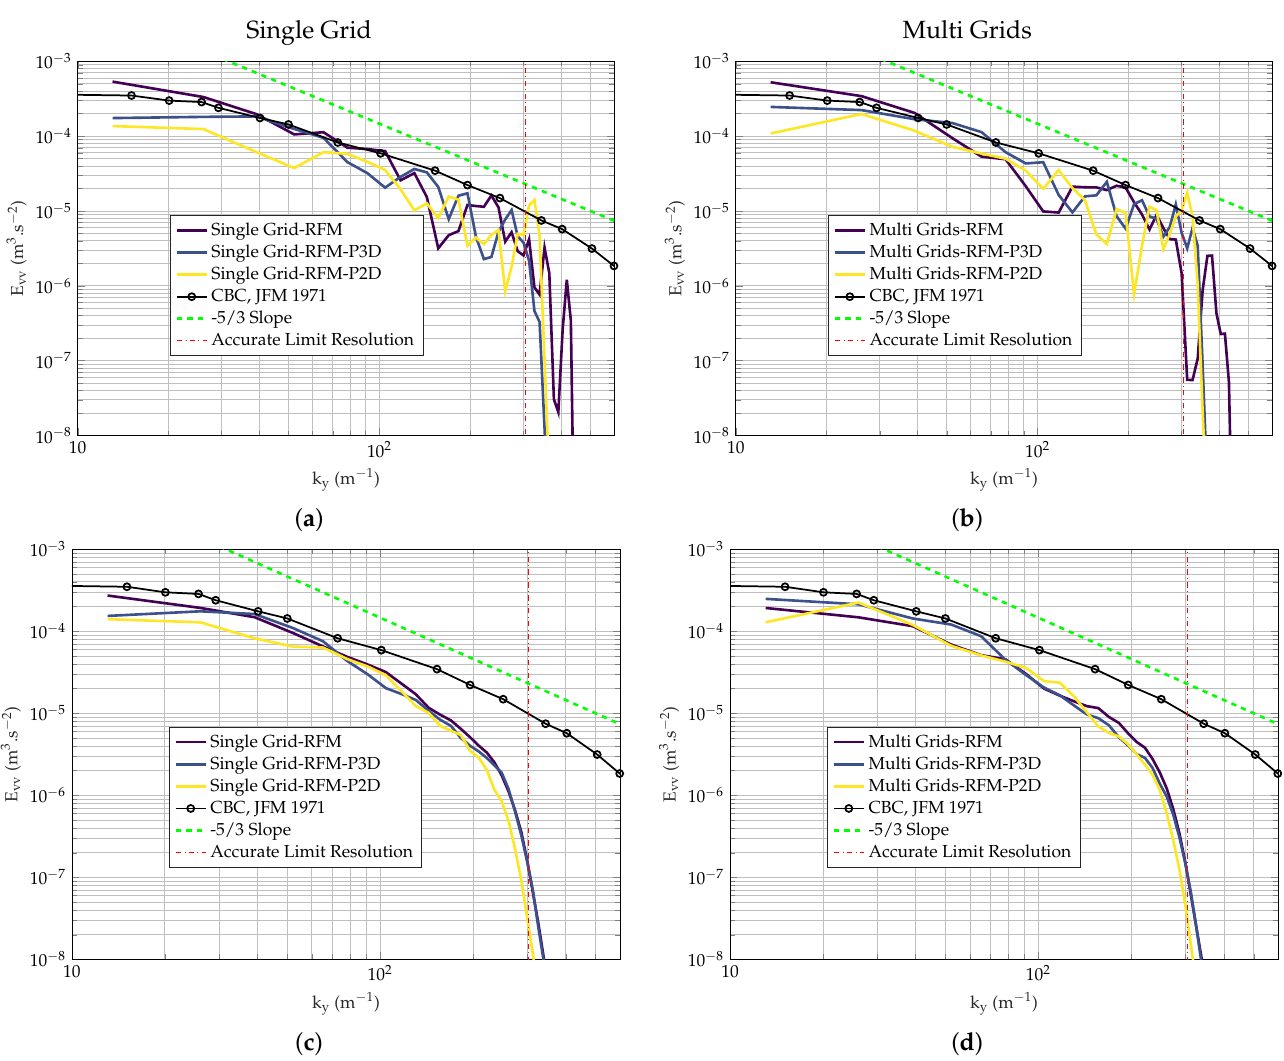
Figure 10. One-dimensional spectra at x = 0 for configurations ( a ) Single Grid and ( b ) Multi Grids, and at x = 90 Λ f for configurations ( c ) Single Grid and ( d ) Multi Grids. CBC curve represents the Comte-Bellot and Corrsin experiment results [40] on their first measurement